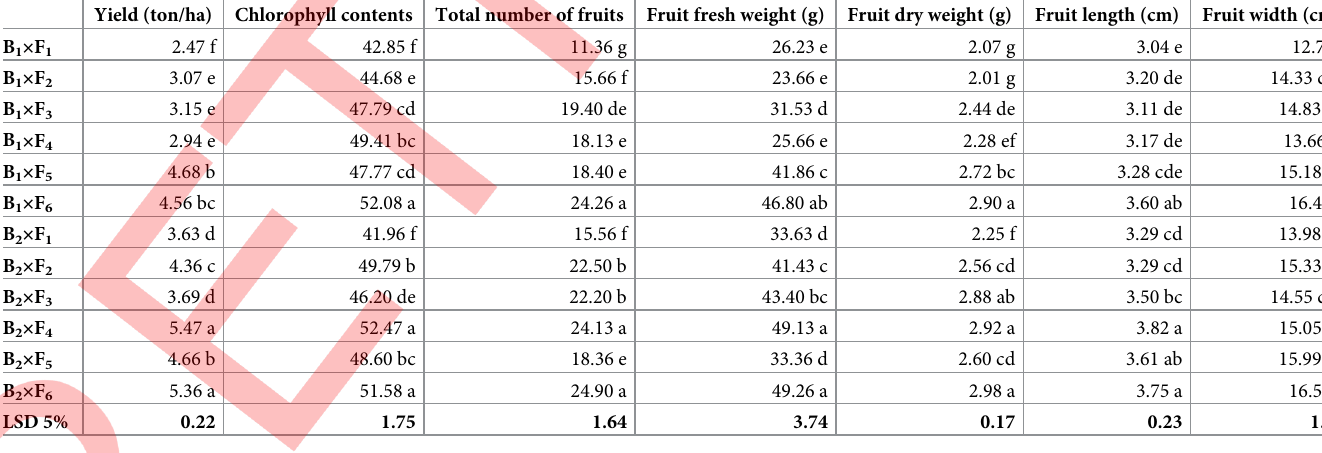
Table 4. The impact of different rhizobacteria inoculation on reproductive traits and yield of chili grown under different nitrogen